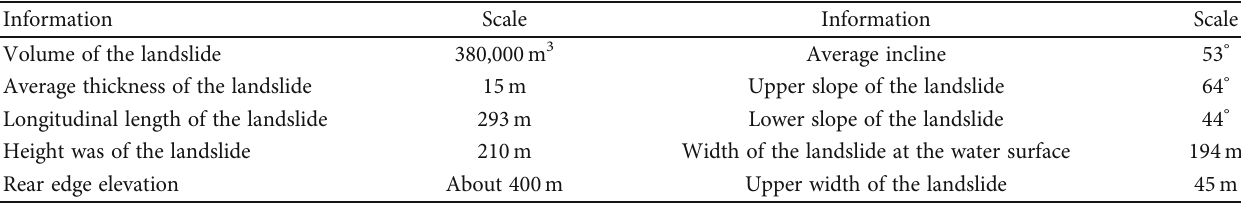
Figure 4: The regional location map and site pictures of the Gongjiafang landslide [39]. Table 2: The main information of the Gongjiafang landslide